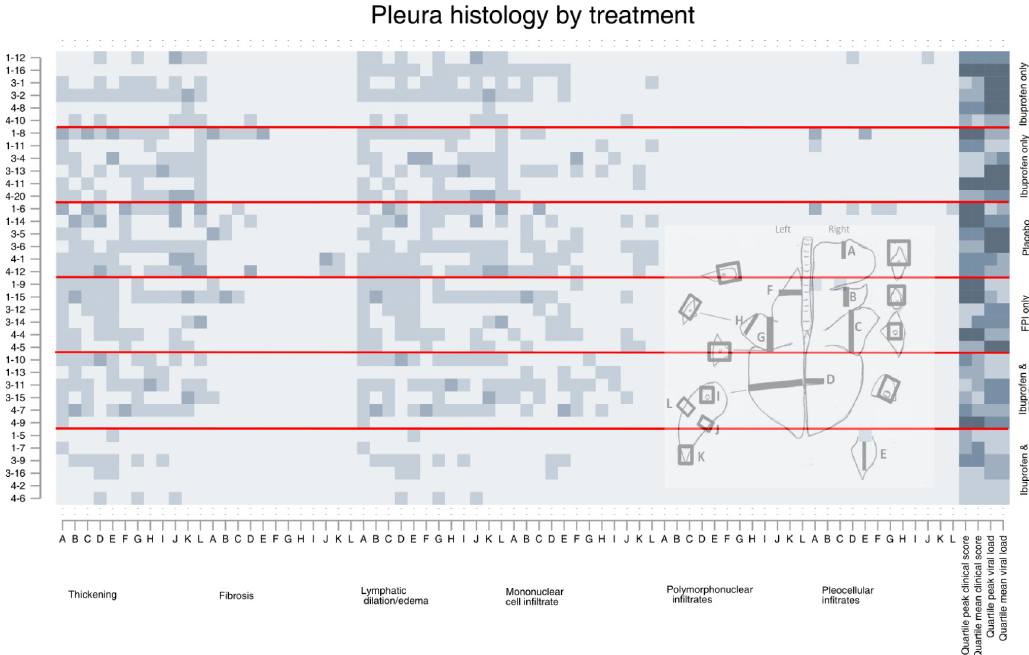
Fig 2. Pleural histology findings by drug treatment group. Each row represents an individual calf, each letter represents a slide, the x-axis colors indicate a different specific histological finding. The shading of each pixel represents the severity of the finding on a scale of 0 (light) to 3 (darker). On the y-axis the first number represents the batch/replicate number, the number following the dash the ear tag for the individual calf. The horizontal red lines divide the treatment groups. The last four columns represent quartiles (first lightest, fourth darkest) of mean peak and clinical scores and mean peak viral loads measured by nasal